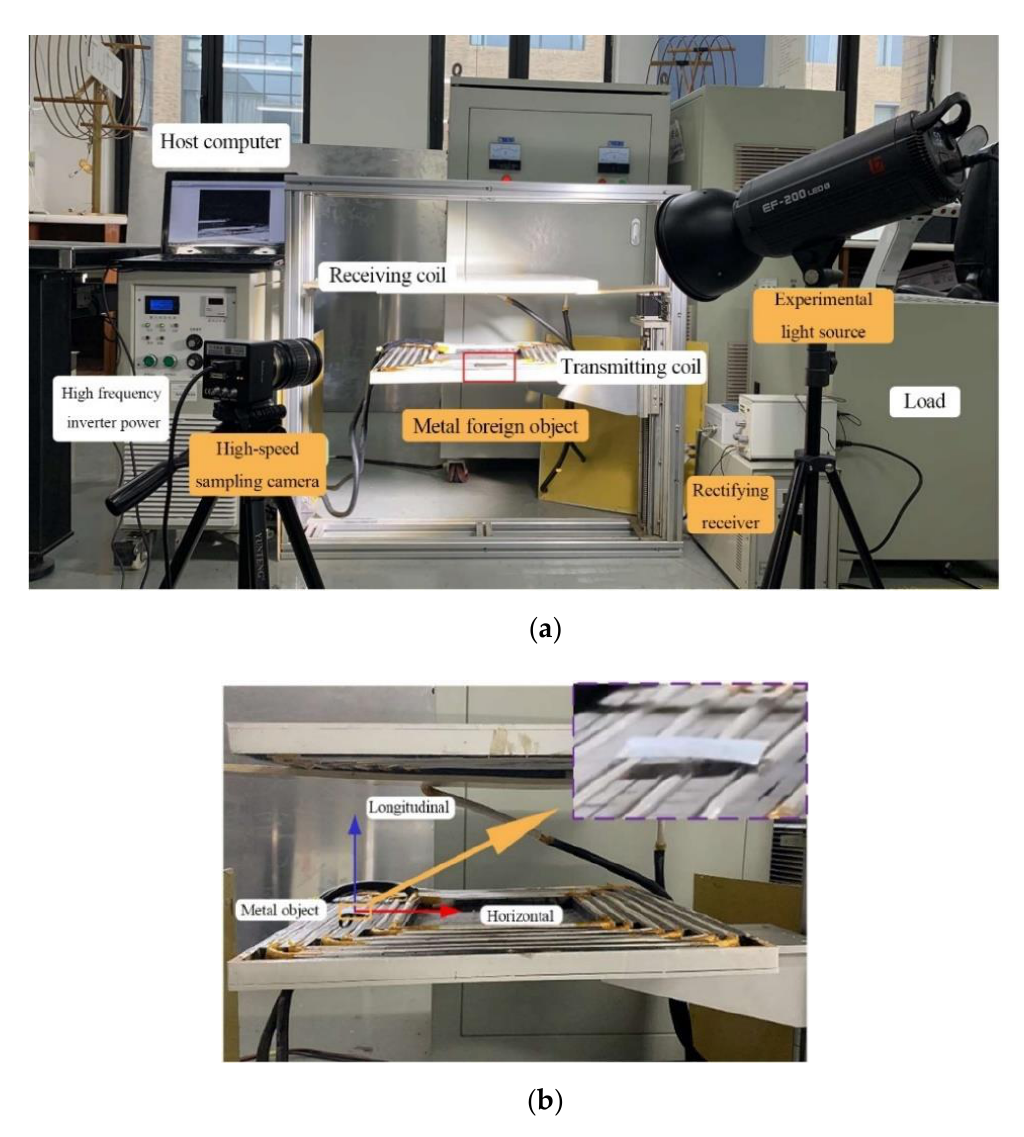
Figure 8. Prototype of the high-power WPT system and data acquisition device. ( a ) Experiment platform; ( b ) schematic of metal foreign bodies.